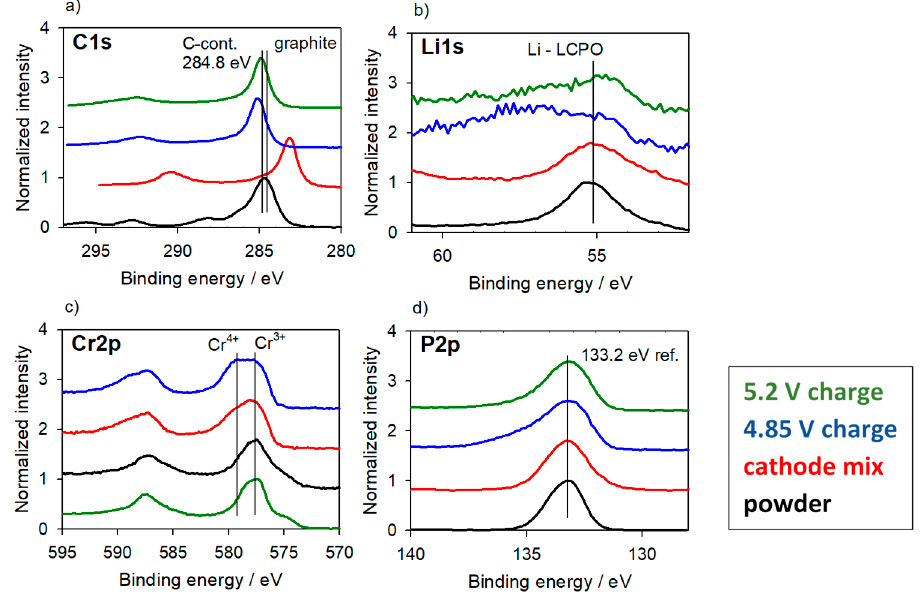
Figure 10. XP spectra normalized in intensity of pure Li 3 Cr 2 (PO 4 ) 3 active material and as cathode mix (Li 3 Cr 2 (PO 4 ) 3 , carbon black, binder) and charged (delithiated) up to 4.85 and 5.2 V ( bottom to top ). C1s from contamination was utilized for BE correction (284.8 eV) for the pure Li 3 Cr 2 (PO 4 ) 3 material; afterwards the P2p peak was used for a second calibration at the resulting BE of 133.2 eV. C1s mainly from carbon black cannot be used as reference because of differential charging. For the Cr peak a change to the higher valence state Cr 4+ is observed at delithiation. ( a ) C1s; ( b ) Li1s; ( c ) Cr2p; ( d ) P2p